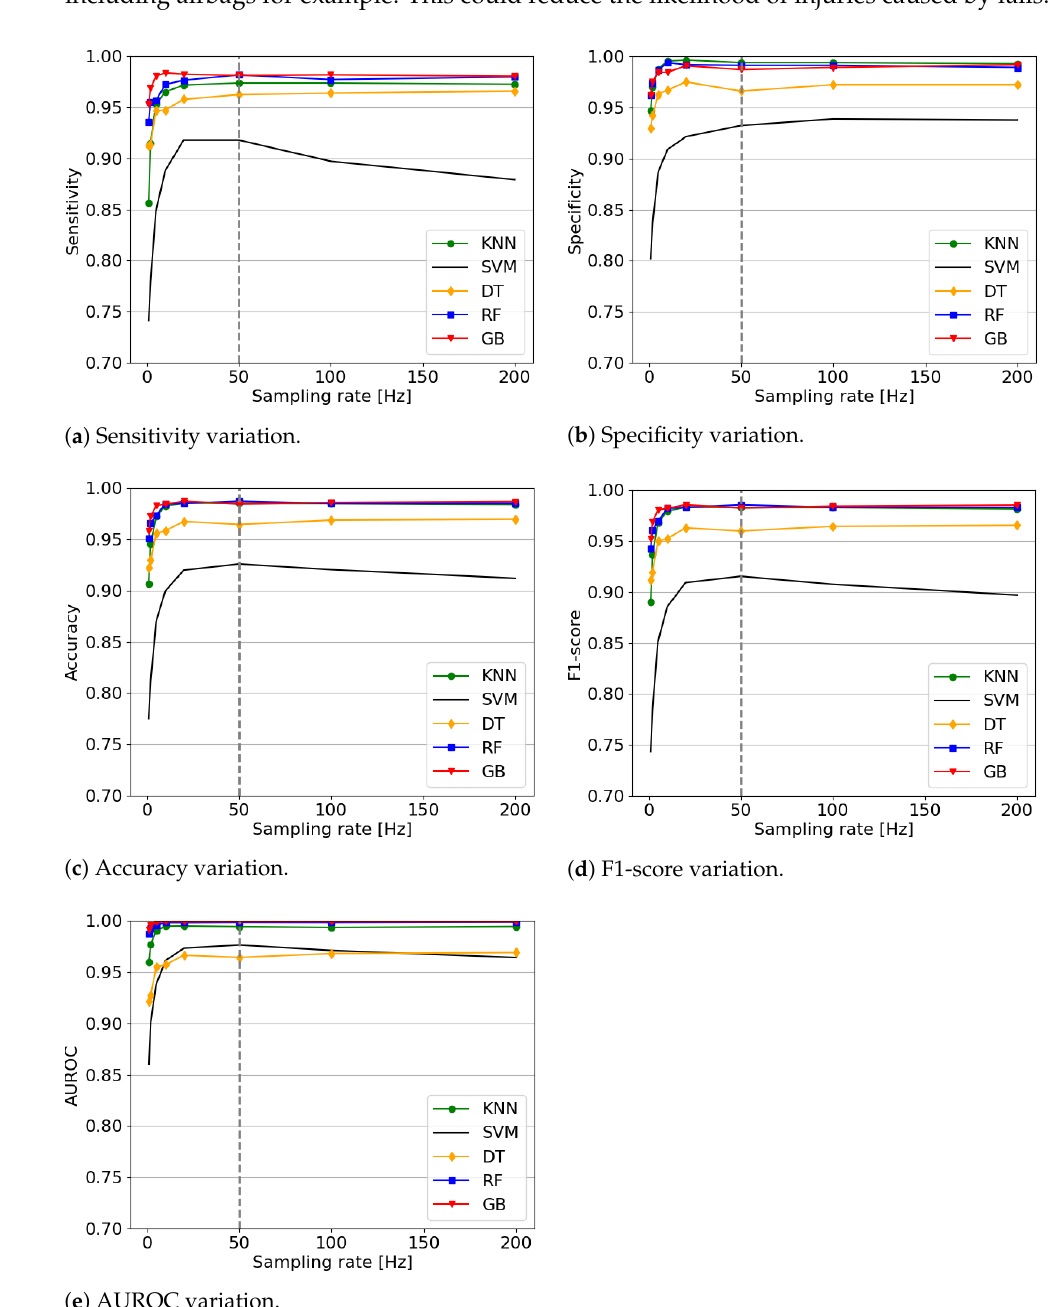
Figure 4. Metrics variation over the sampling rates of five algorithms. The highest average metrics across all algorithms is obtained with a sampling of 50